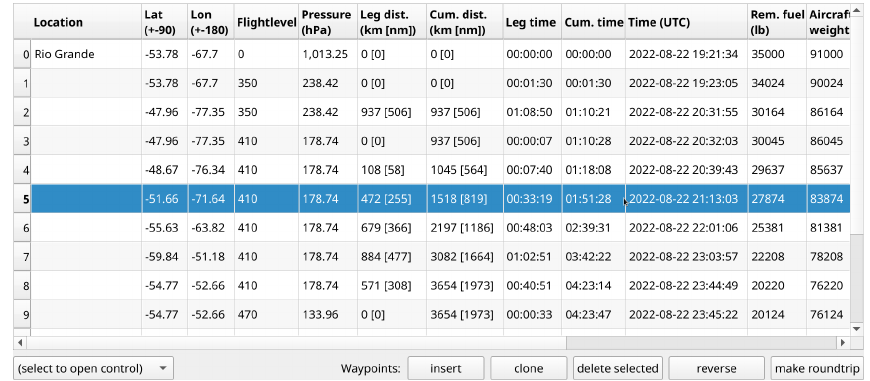
Figure 4. The table view window of the